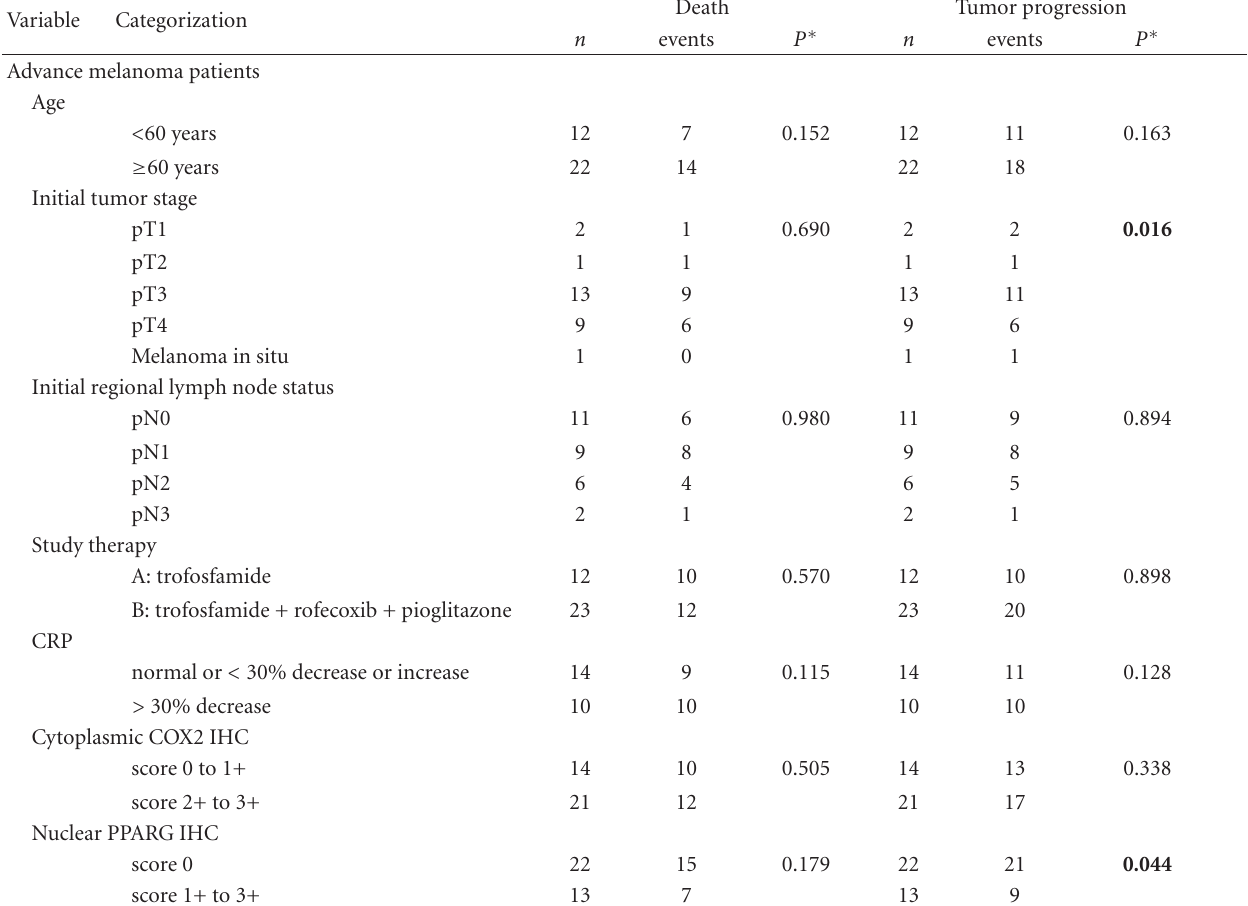
Table 4: Univariate analysis of factors regarding tumor progression and death using TMA-3.